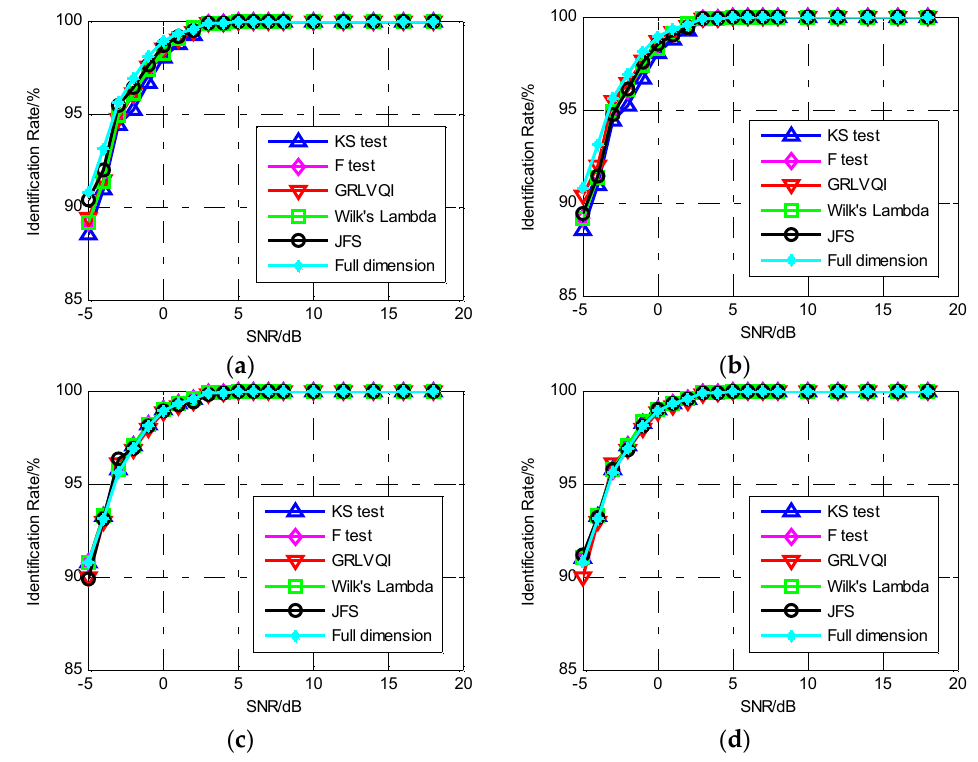
Figure 5. The performance of the support vector machine (SVM) classification for six classes using IMF-DNA. ( a ) N d = 10. ( b ) N d = 30. ( c ) N d = 50. ( d ) N d = 80.